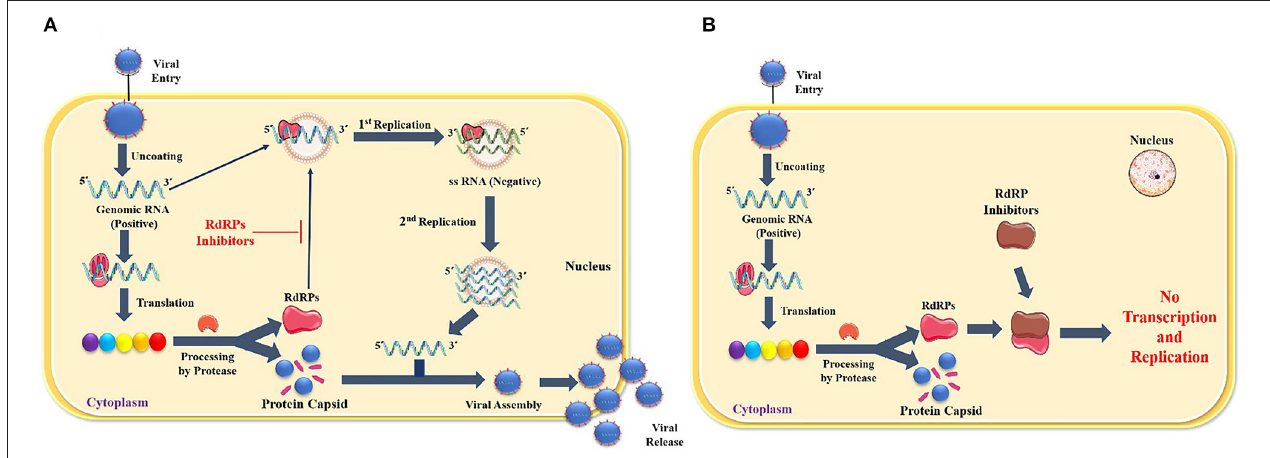
FIGURE 1 | (A) Role of RdRp in viral replication, (B) Effect of RdRp